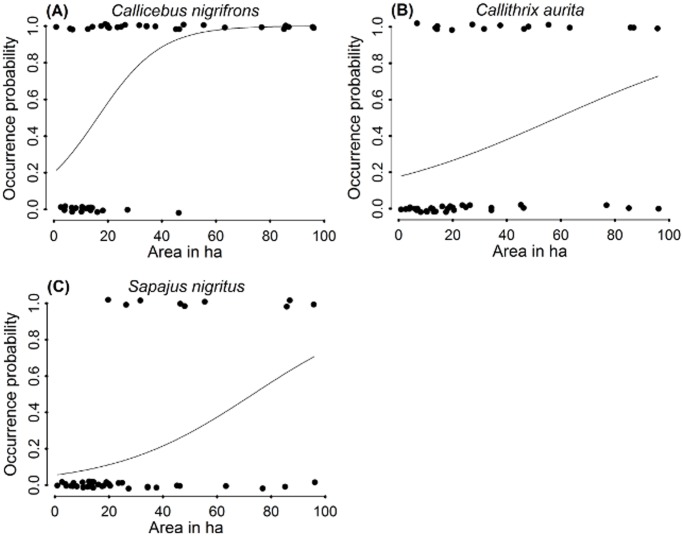
Fitted logistic regression curves for the occurrence of the studied primate species against best predictor, fragment area.(A) Callicebus nigrifrons, (B) Callithrix aurita and (C) Sapajus nigritus.